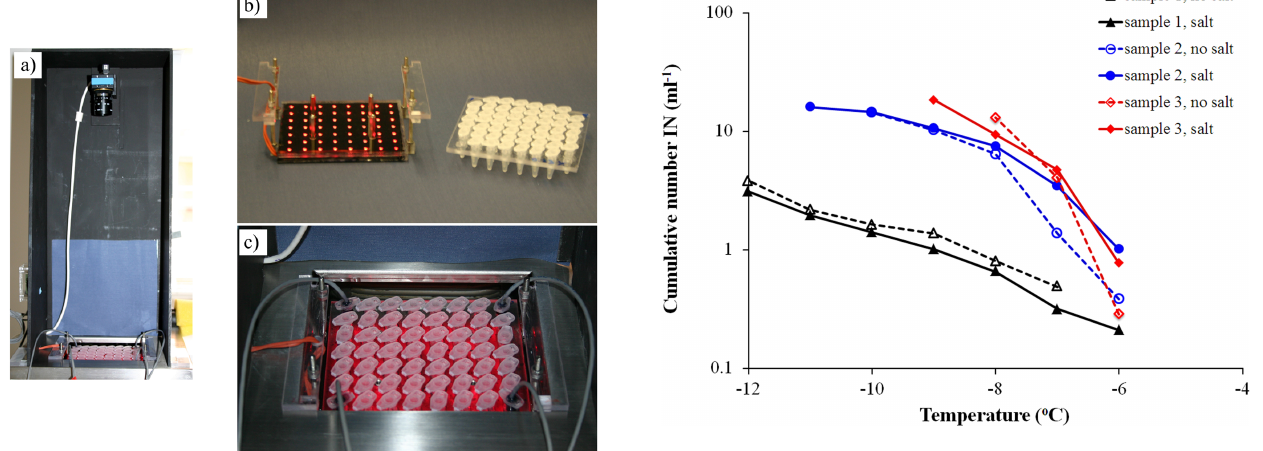
Fig. 2. Paired snow water samples without (open symbols) and with (closed symbols) NaCl (0.9%). Each spectrum based on man- ual/visual analysis of 54 tubes at